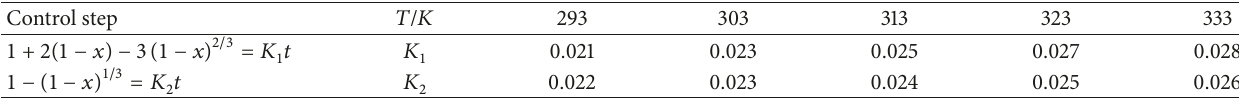
Table 1: Reaction rate constant at different temperatures.